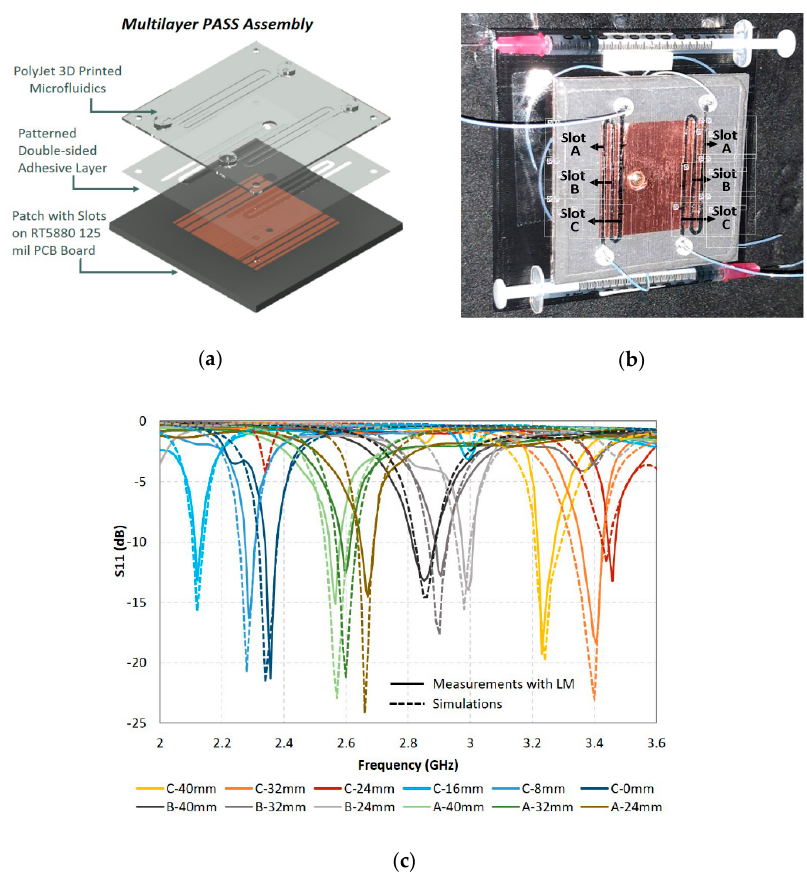
Figure 9. ( a ) Exploded view of the prototype PASS antenna design with VeroClear 3D-printed microfluidics; ( b ) fabricated PASS antenna with labelled slots filled with EGaIn carried by mineral oil; ( c ) PASS S11 parameters as a function of frequency measured for various slot lengths [38].